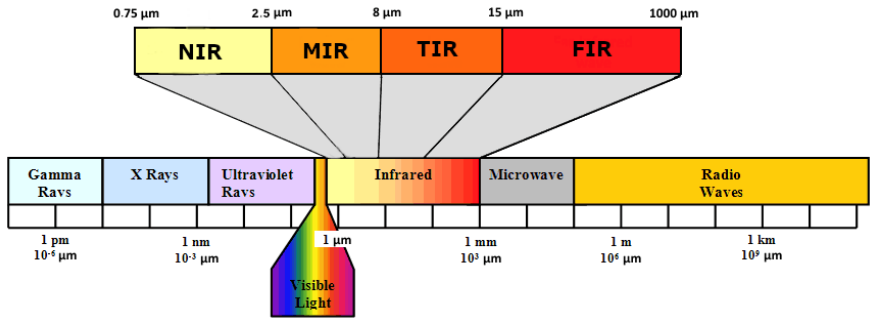
Figure 3. Representation of the Electromagnetic